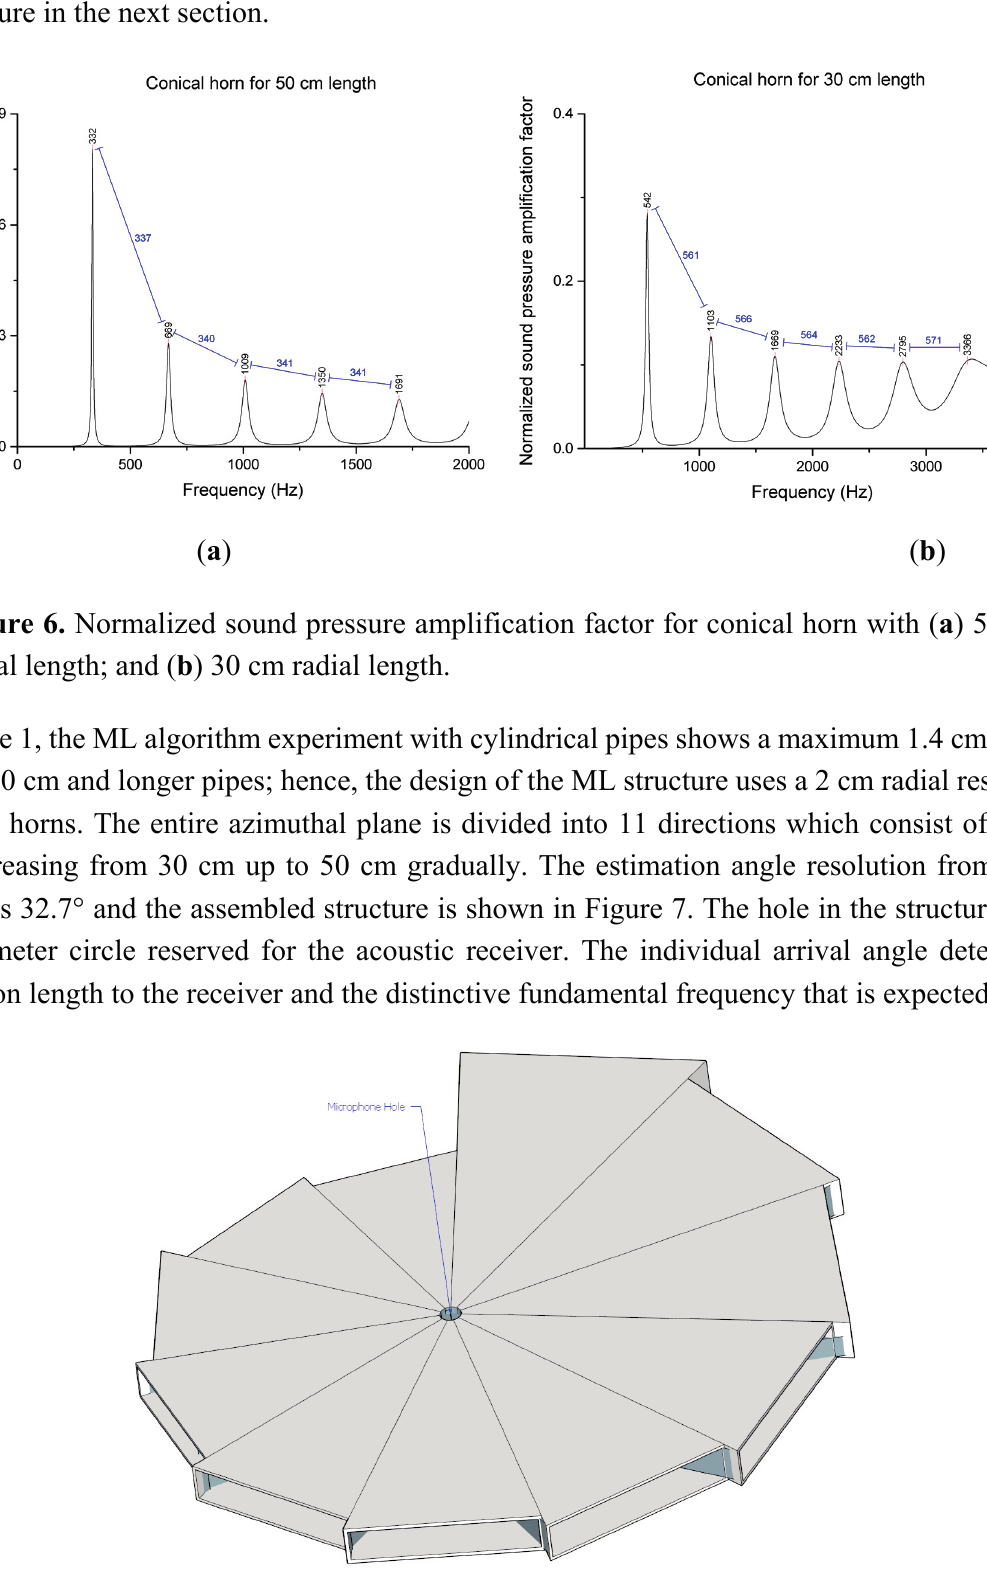
Figure 7. Designed ML